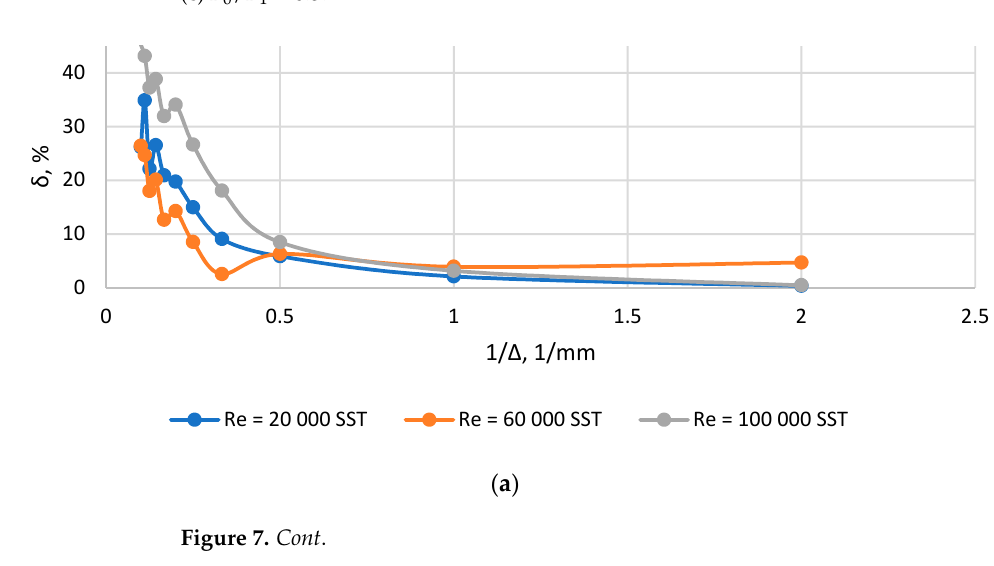
Figure 6. Plots δ (1/ Δ ) for channel with sudden contraction: ( a ) F 0 /F 1 = 0.1; ( b ) F 0 /F 1 = 0.3; ( с ) F 0 /F 1 = 0.5.